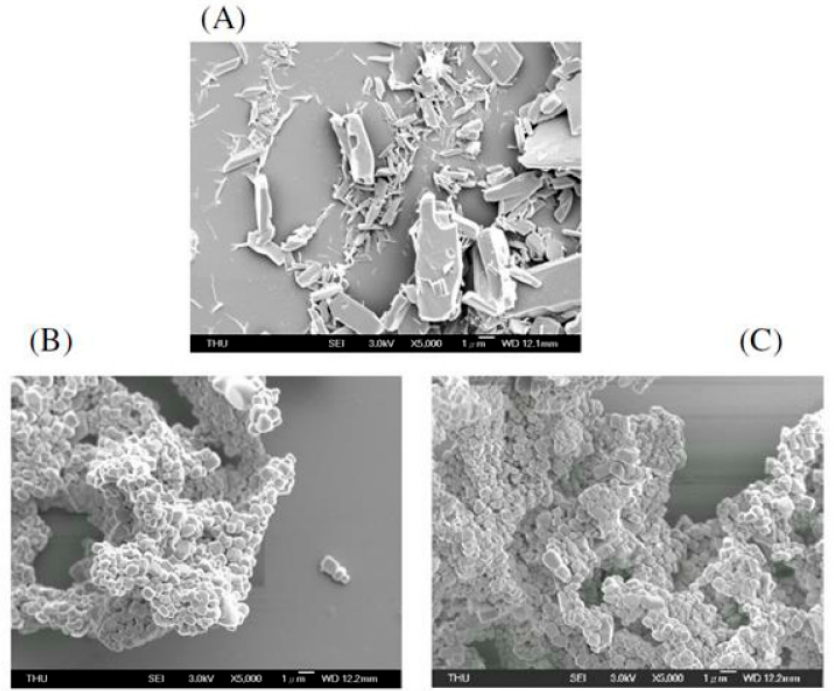
Figure 1. Representative field emission scanning electron microscope (FE-SEM) images of free Astaxanthin (AST), AST encapsulated within liposomes and free liposomes. Free AST ( A ); free liposome only (228 ± 32 nm) ( B ); and AST encapsulated within liposomes (LA) (240 ± 58 nm) ( C ) (magnification 5000×).